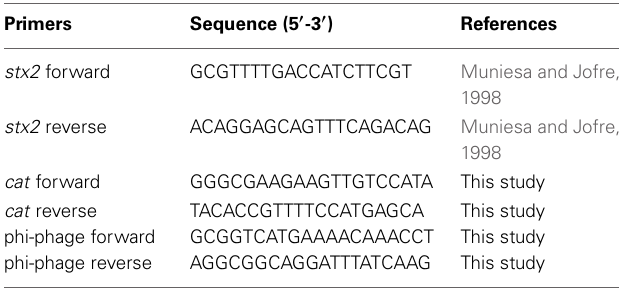
Table 2 | PCR primers used in the study.